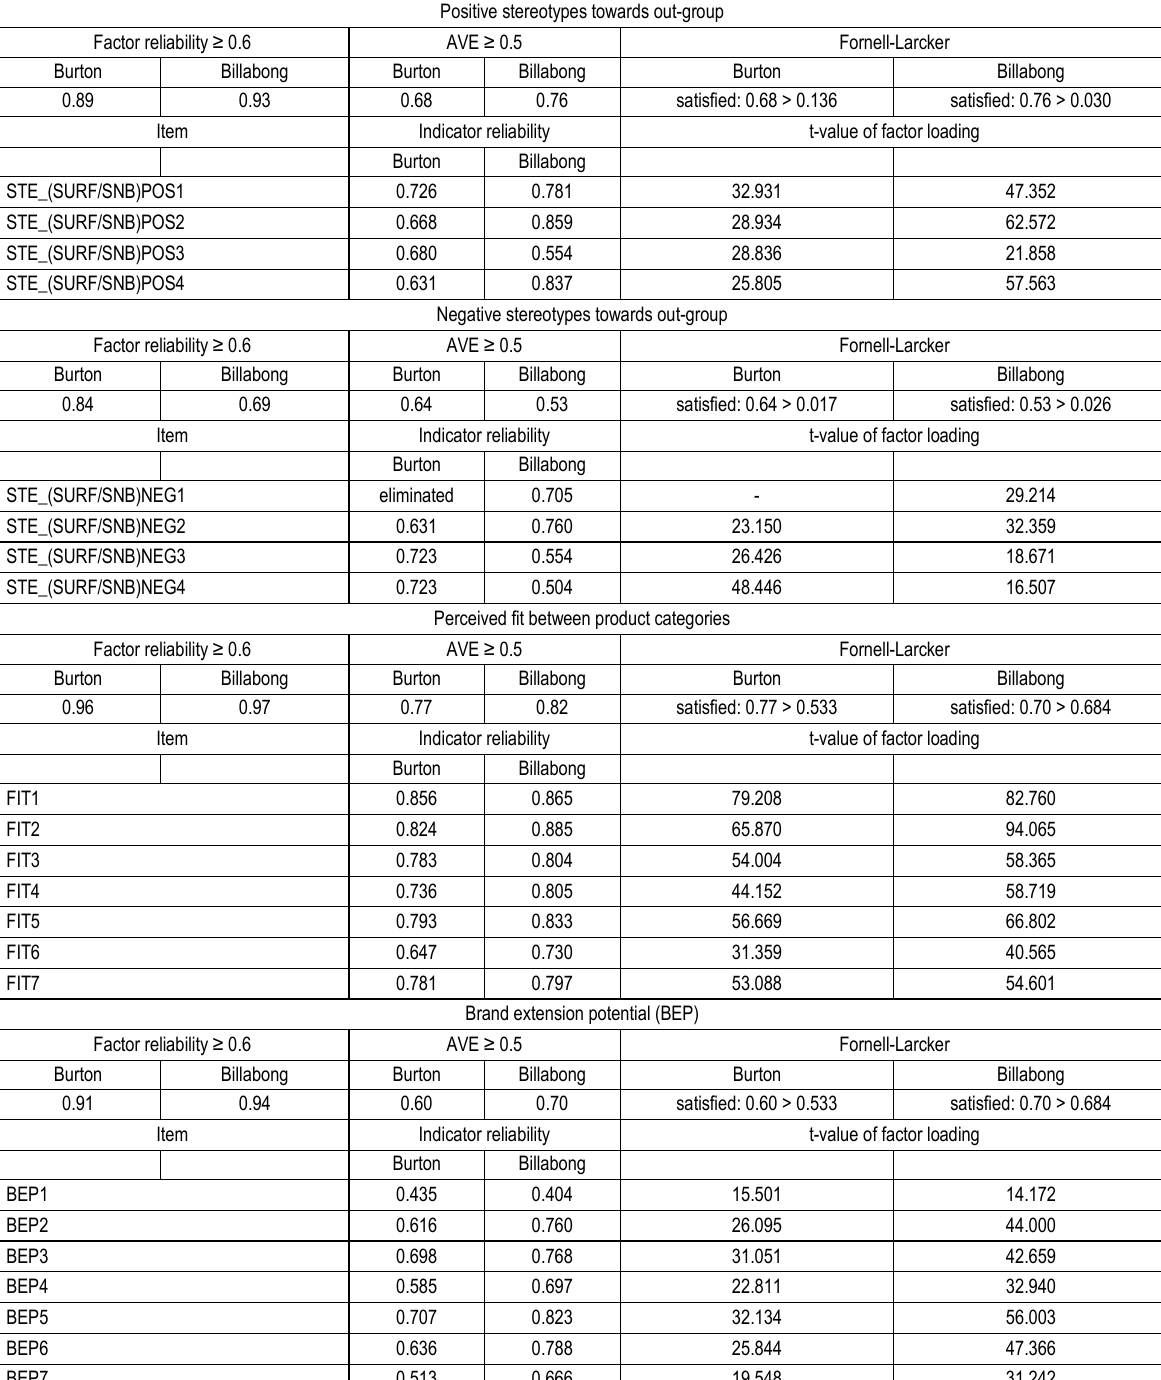
Table 6 (cont.). Local measures of goodness of the individual constructs Positive stereotypes towards